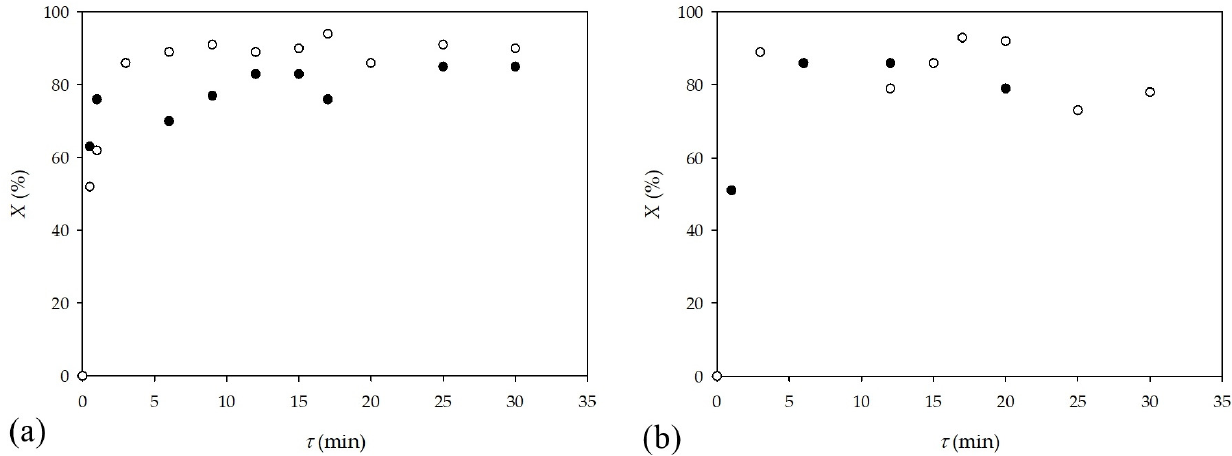
Figure 8. The influence of residence time on conversion for the reaction catalyzed by ( a ) free-base porphyrin and ( b ) Mn(III) porphyrin ( ◦ anionic, • cationic). As expected, the reactions were significantly accelerated in microflow reactors, where conversions higher than 80% were observed after 5 min for free-base porphyrins and for Mn(III) porphyrins, respectively probably due to higher and more homogenous irradiation over the whole microreactor surface [4]. The same results were obtained in our